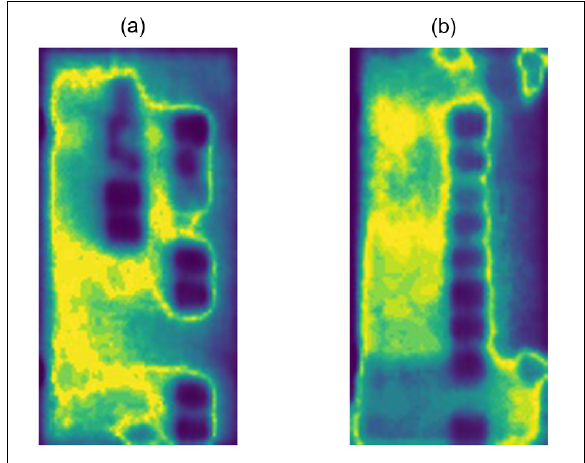
Figure 3: Thermal image showing (a) patchwork and (b) string faults.